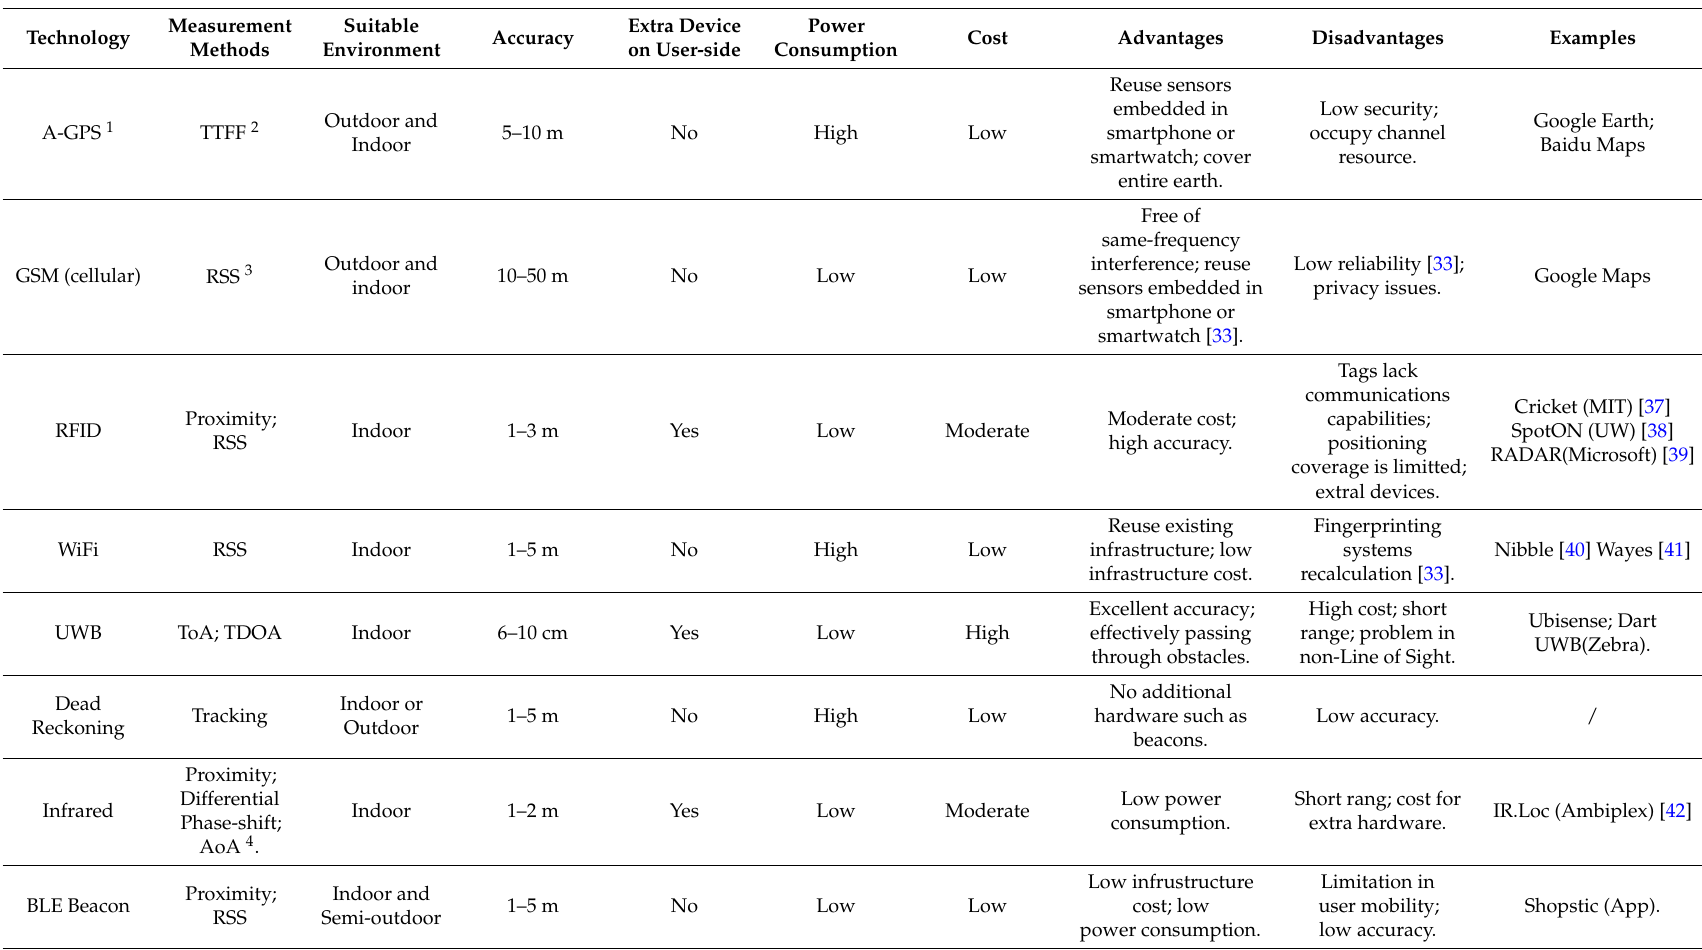
Table 1. Comparison of indoor positioning